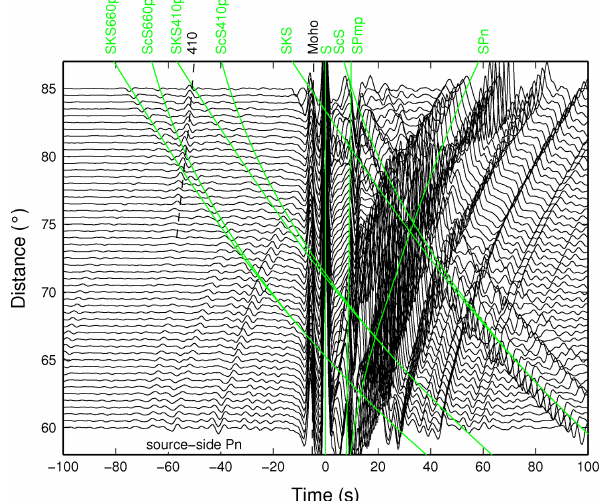
Figure 6. Theoretical seismograms (vertical component) computed with the reflectivity method for comparison with the observed data in Fig. 3a. The strong SPn phase after S agrees well with the data in Fig. 3a. A disagreement between computed and observed seis- mograms is the source-side Pn in front of the S signal (this figure) which is not in the data (Fig. 3a). This is a phase traveling as P along the surface on the source side and is continuously radiating S waves downward. At the receiver side these phases are converted back to P and travel again horizontally along the uppermost mantle and are observed on the vertical component. These phases are not observed in the real data probably because of heterogeneities in the real